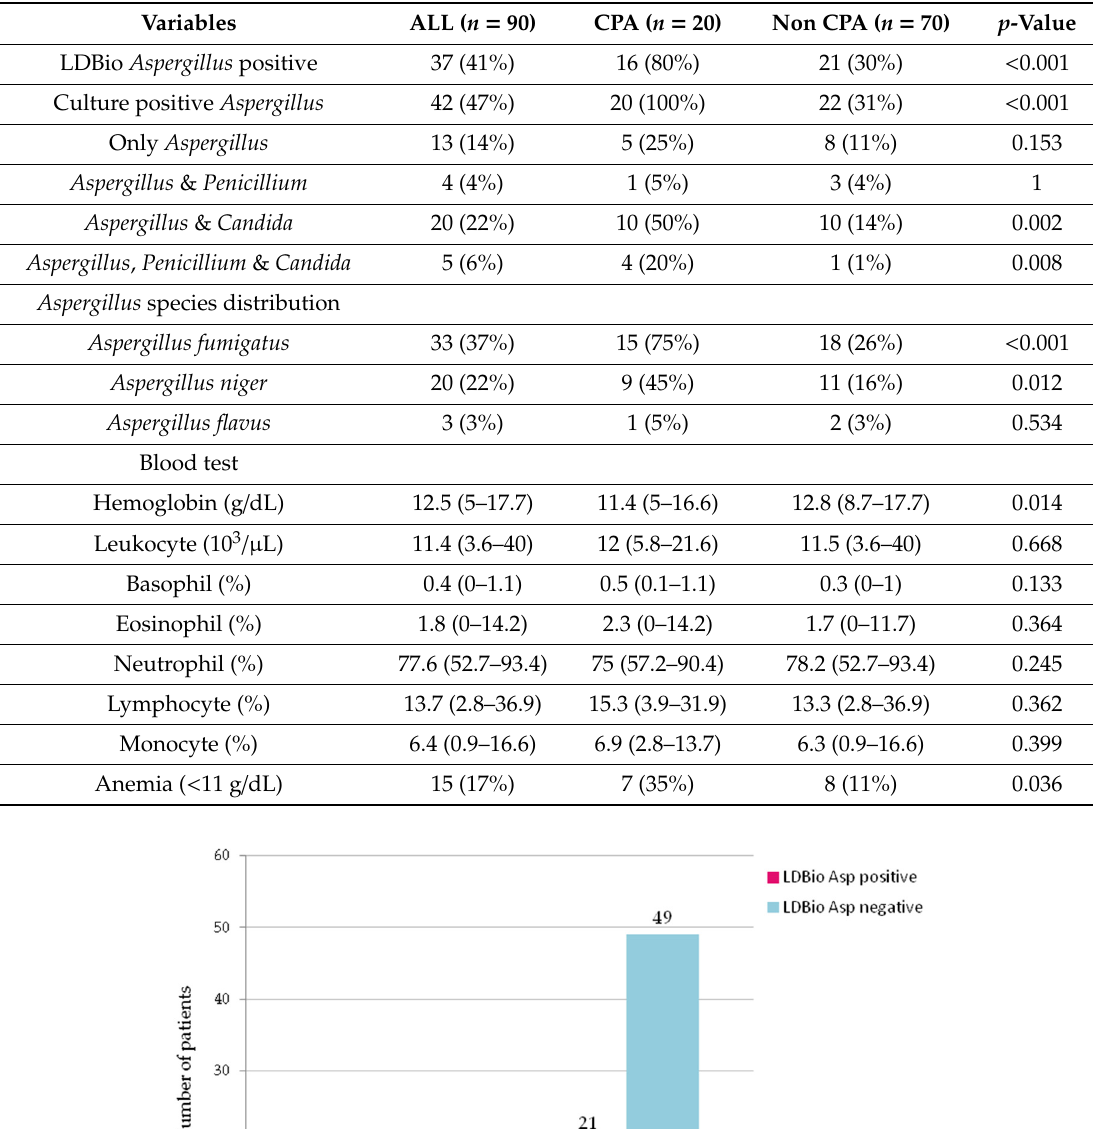
Table 2. Laboratory results.